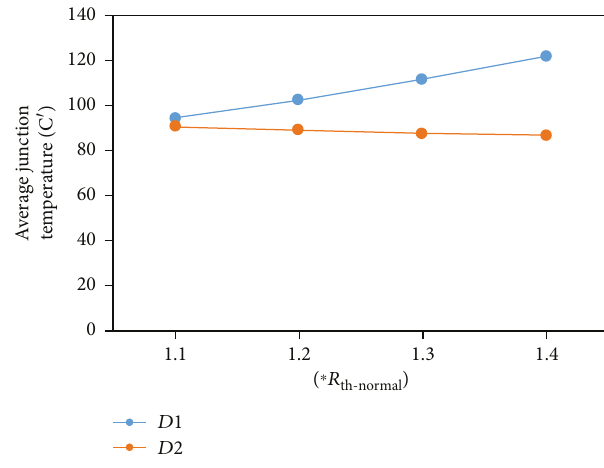
Figure 14: The average junction temperature.